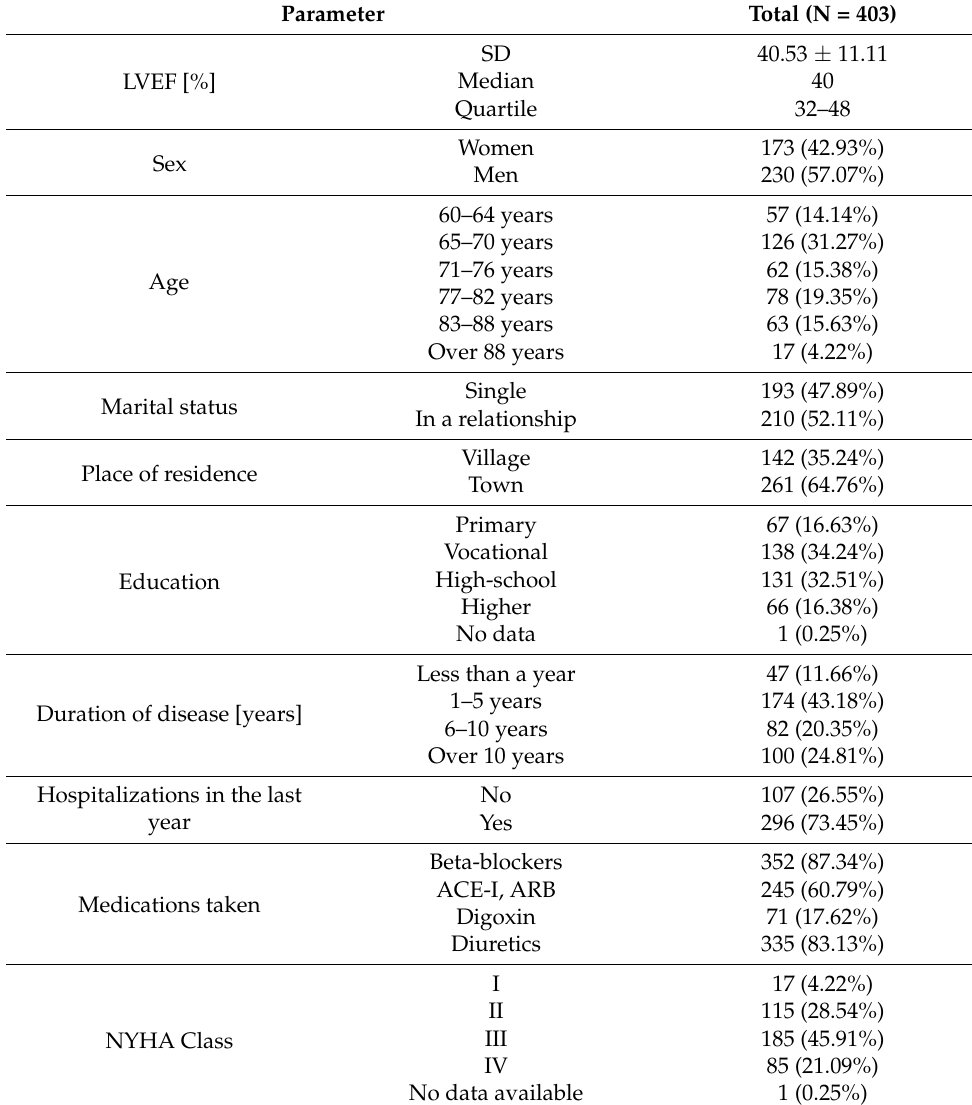
Table 1. Sociodemographic and clinical data of the study group (n = 403).